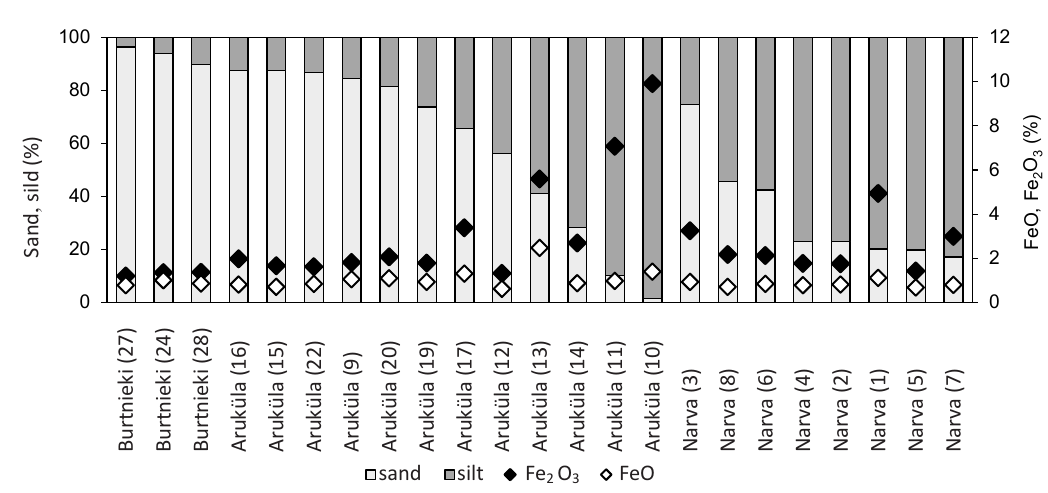
Fig. 8. The share of sand and silt fractions and the content of Fe 2 O 3 and FeO in the studied Devonian rock samples. The numbering of the rock samples is in accordance with Table 1.